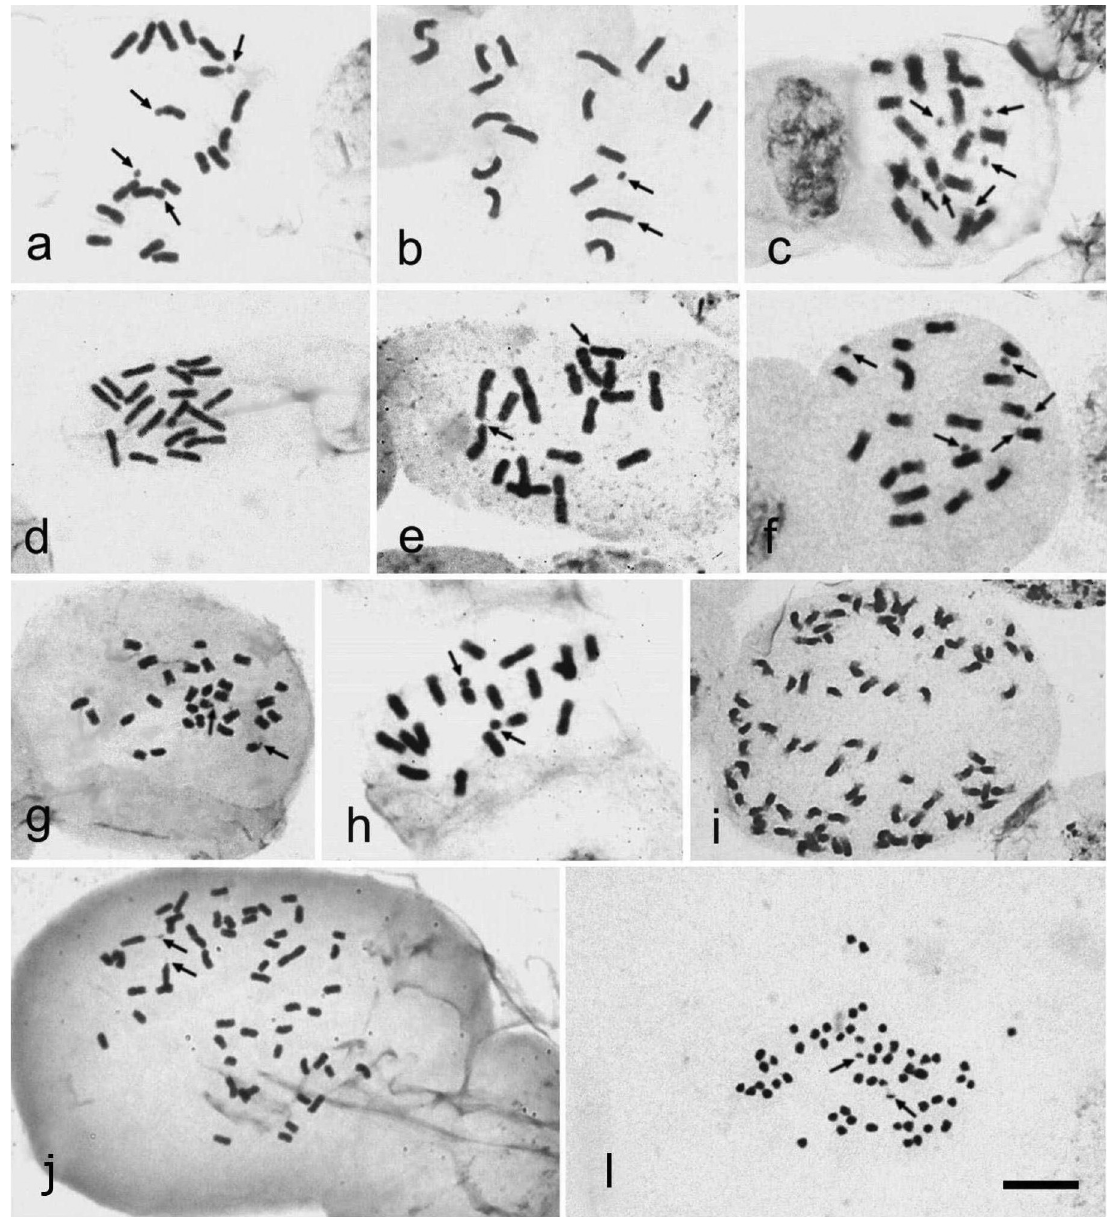
Figure 2 - Mitotic metaphase and interphase nuclei of species of the Tribe Trimezieae from northeastern Brazil: (a) Neomarica candida with 2 n = 18 and foursatellites;(b) N.caerulea with2 n =18andtwosatellites;(c) N.glauca with2 n =18andsixsatellites;(d) N.gracilis (2 n =18);(e) N.humilis (2 n =18) withonesatellitedpair;(f) N.northiana with2 n =18andfivesatellites;(g) N. cf. paradoxa with2 n =28andtwosatellites;(h) Neomarica sp.with2 n =18 and two satellites; (i) Trimezia connata with 2 n = 82; (j) T . fosteriana with 2 n = 52 and a pair of terminal satellites; (l) T. martinicensis with 2 n = 54 and a distended pair of satellites. Arrows indicate satellites. The bar corresponds to 10 (cid:2)